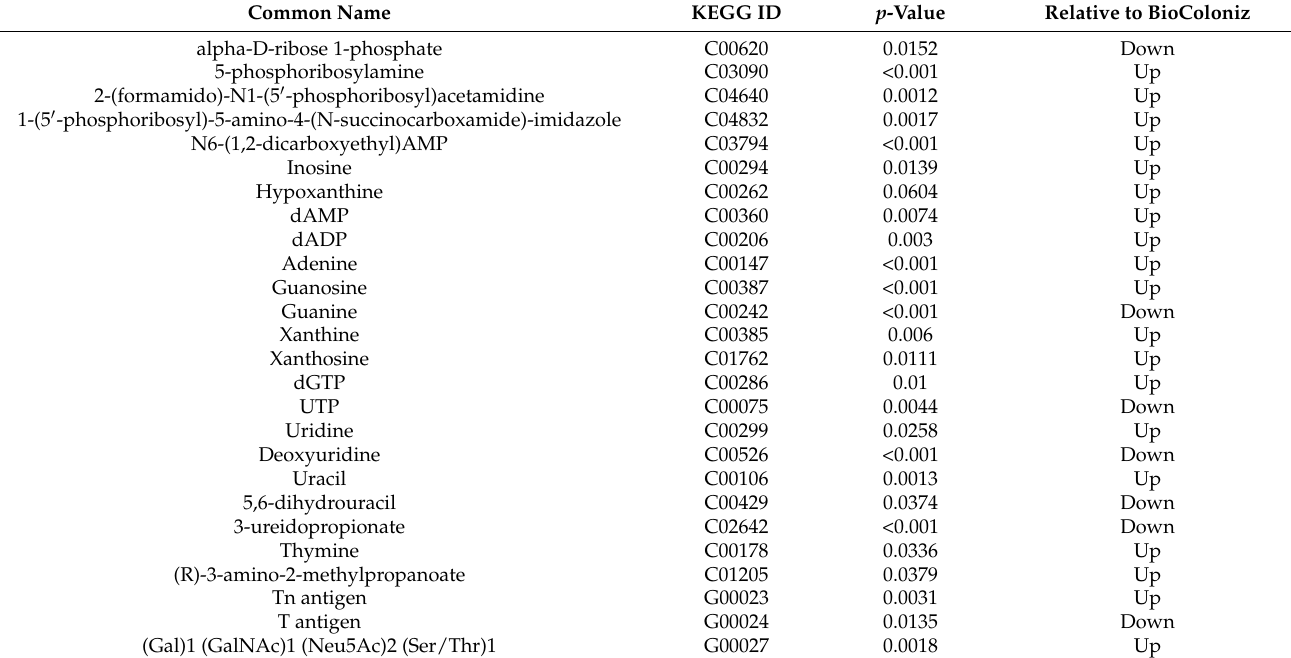
Table 7. Significant features involved in purine, pyrimidine, and O-glycan biosynthesis